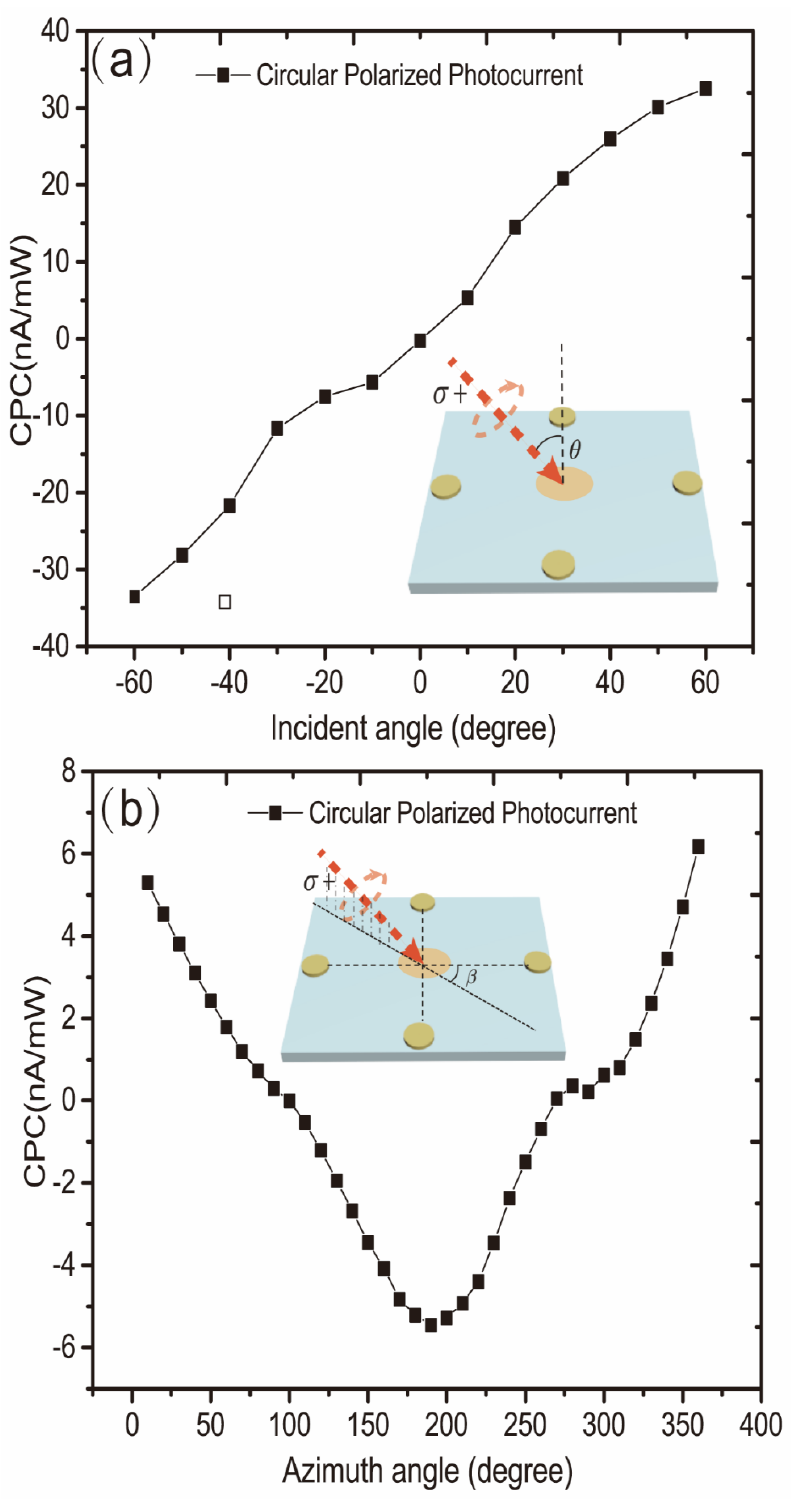
Figure 5. ( a ) The relationship between circularly polarized photocurrent and the incident angle when the azimuth angle is zero; ( b ) the relationship between circularly polarized photocurrent and the azimuth angle when the incident angle is 30°.